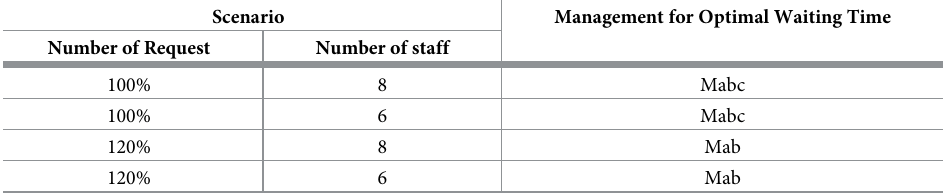
Table 10. The result of the recommended model in each of the